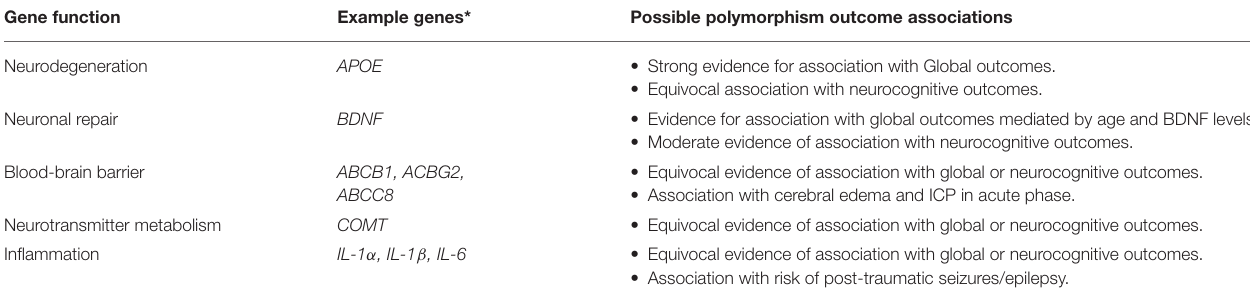
TABLE 2 | SNP categories from candidate genes explored in TBI to date. Gene function Example